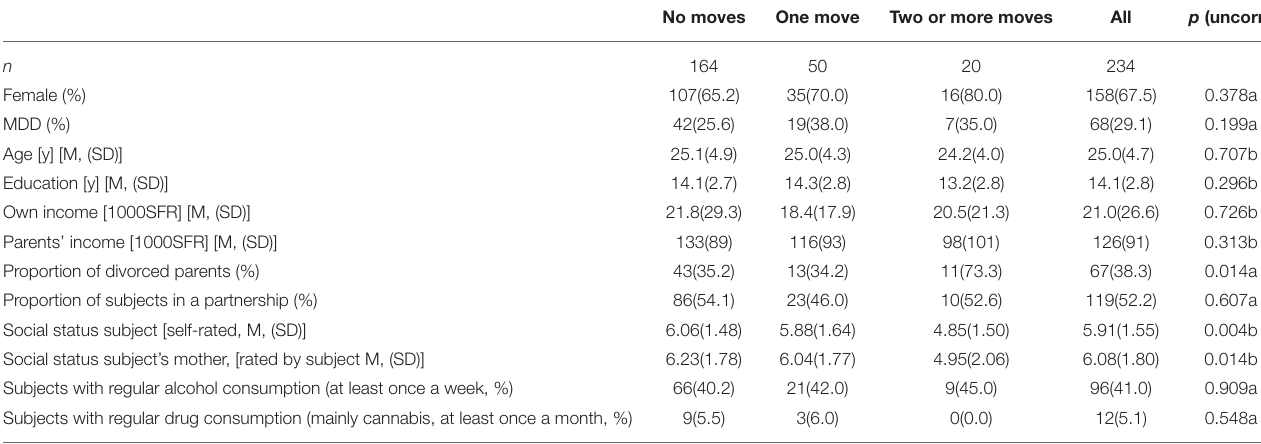
TABLE 1 | Sociodemographic characteristics and residential mobility.